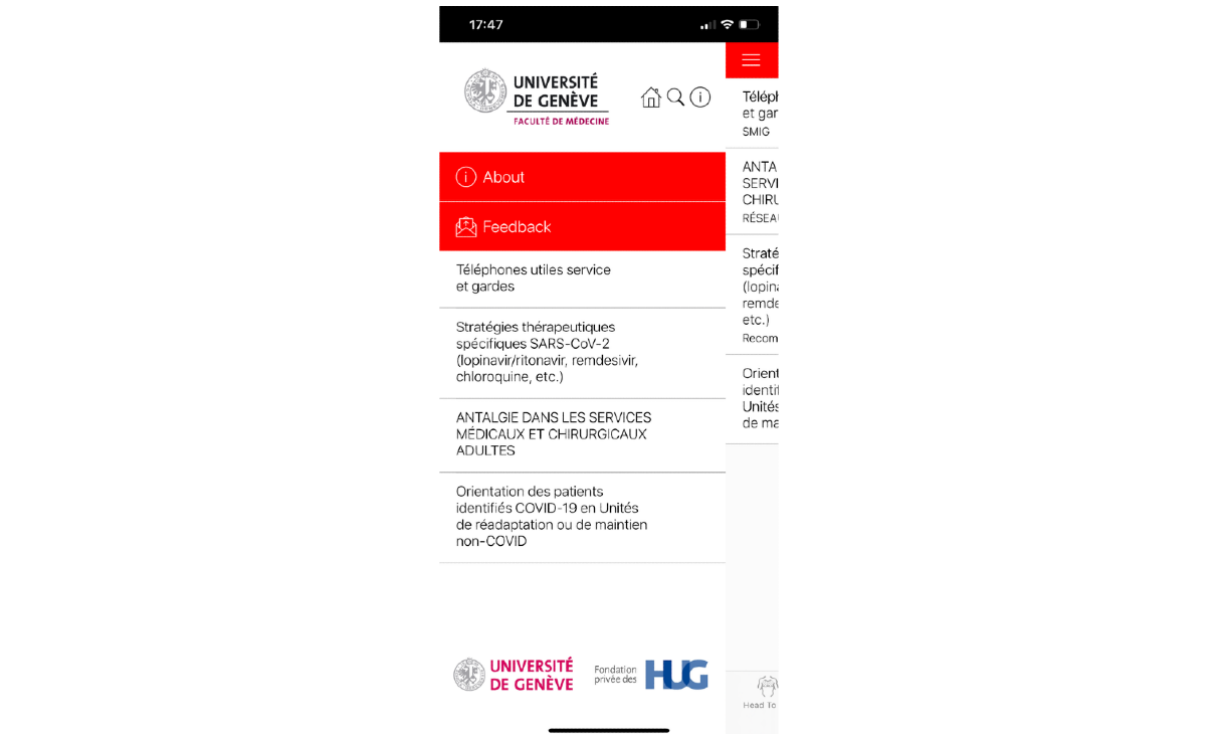
Figure 6. Side menu in the HeadToToe platform (in French). Through this menu, users can quickly access their favorite content and the About menu. Users may also access the Feedback screen and send feedback and questions concerning app use and